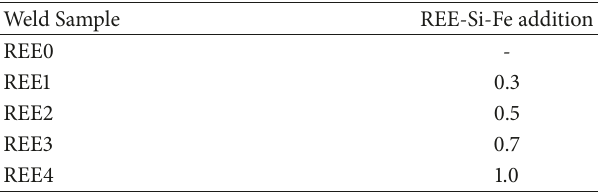
Table 2: Selected content of REE-Si-Fe for the weld samples in flux- cored wire (flux wt.%).